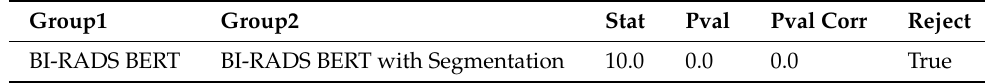
Table A27. McNemar test results for field extraction of